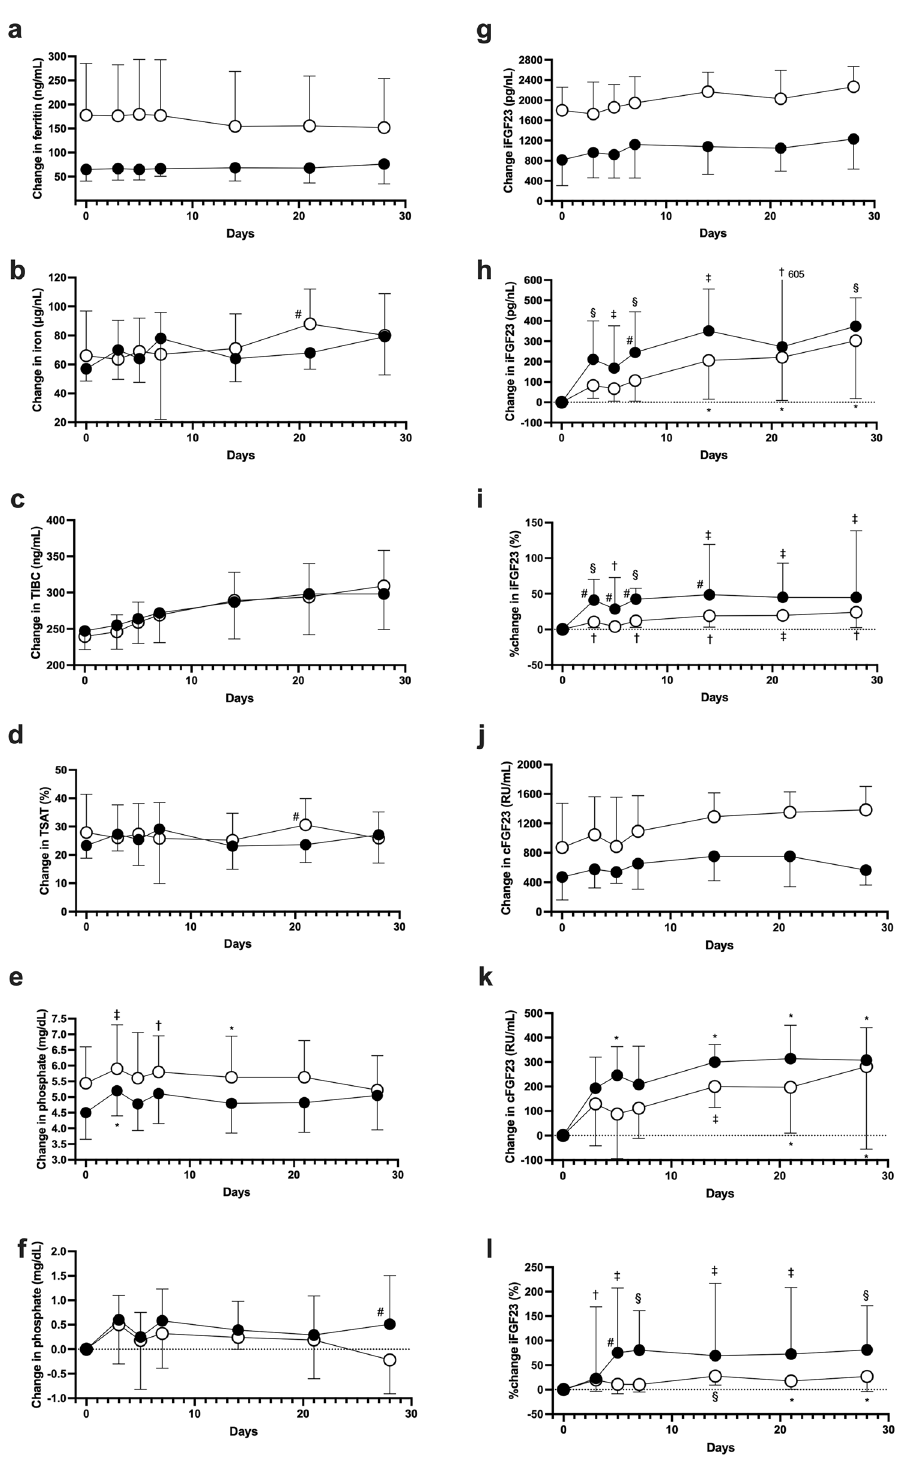
Figure 4. Changes in ferritin, iron, total iron binding capacity (TIBC), transferrin saturation (TSAT), phosphate, and intact and C-terminal fibroblast growth factor 23 (FGF23) levels grouped by the ferritin level with roxadustat treatment. Changes in ferritin ( a ), iron ( b ), TIBC ( c ), TSAT ( d ), phosphate ( e ), delta phosphate ( f ), intact FGF23 (iFGF23) ( g ), delta FGF23 ( h ), C-terminal FGF23 (cFGF23) ( j ), delta cFGF23, and percentage changes in iFGF23 ( i ) and cFGF-23 ( l ) grouped by ferritin < 100 (closed circle) or ferritin ≥ 100 ng/ mL (open circle) during roxadustat treatment. Data are shown as means ± standard deviation ( a – f ) or medians (interquartile range) ( g – l ) and compared between the value at day 0 and the target value. *p < 0.05, † p < 0.01, ‡ p < 0.001, § p < 0.0001. # Means significant differences between the